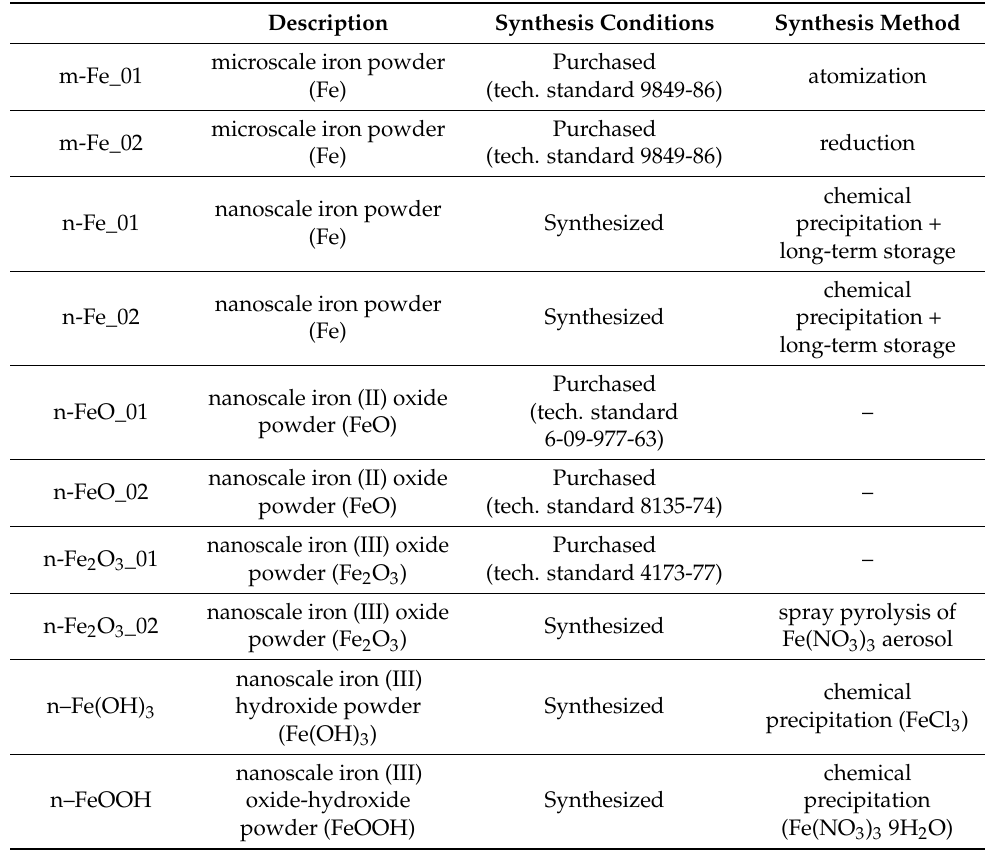
Table 1. Description of initial powder samples.